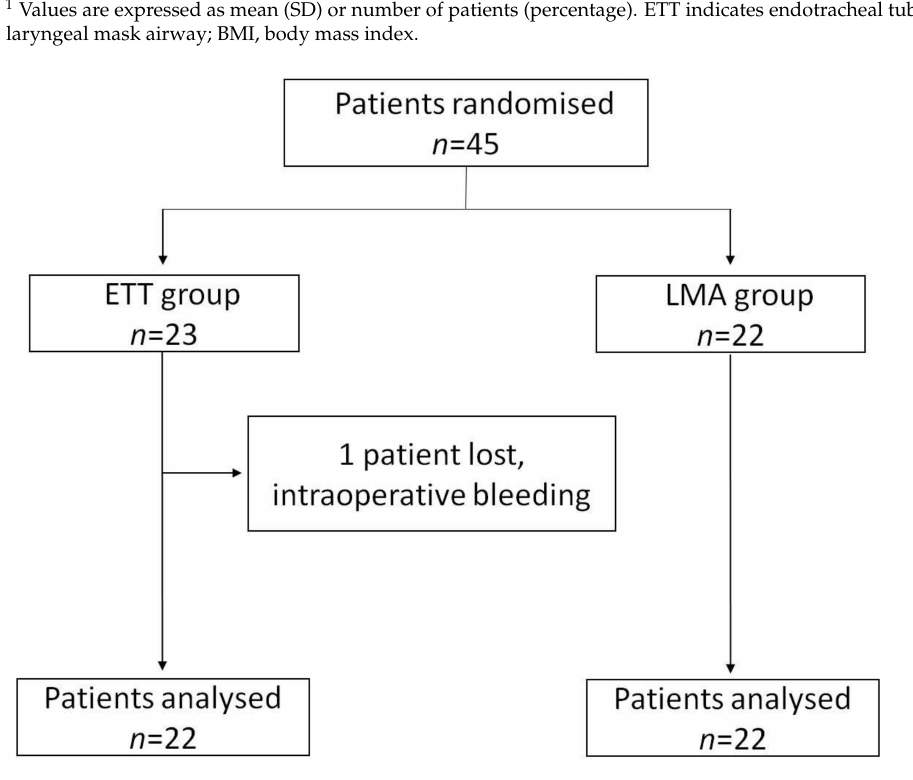
Figure 1. Flow diagram of patient enrolment, one loss, and data